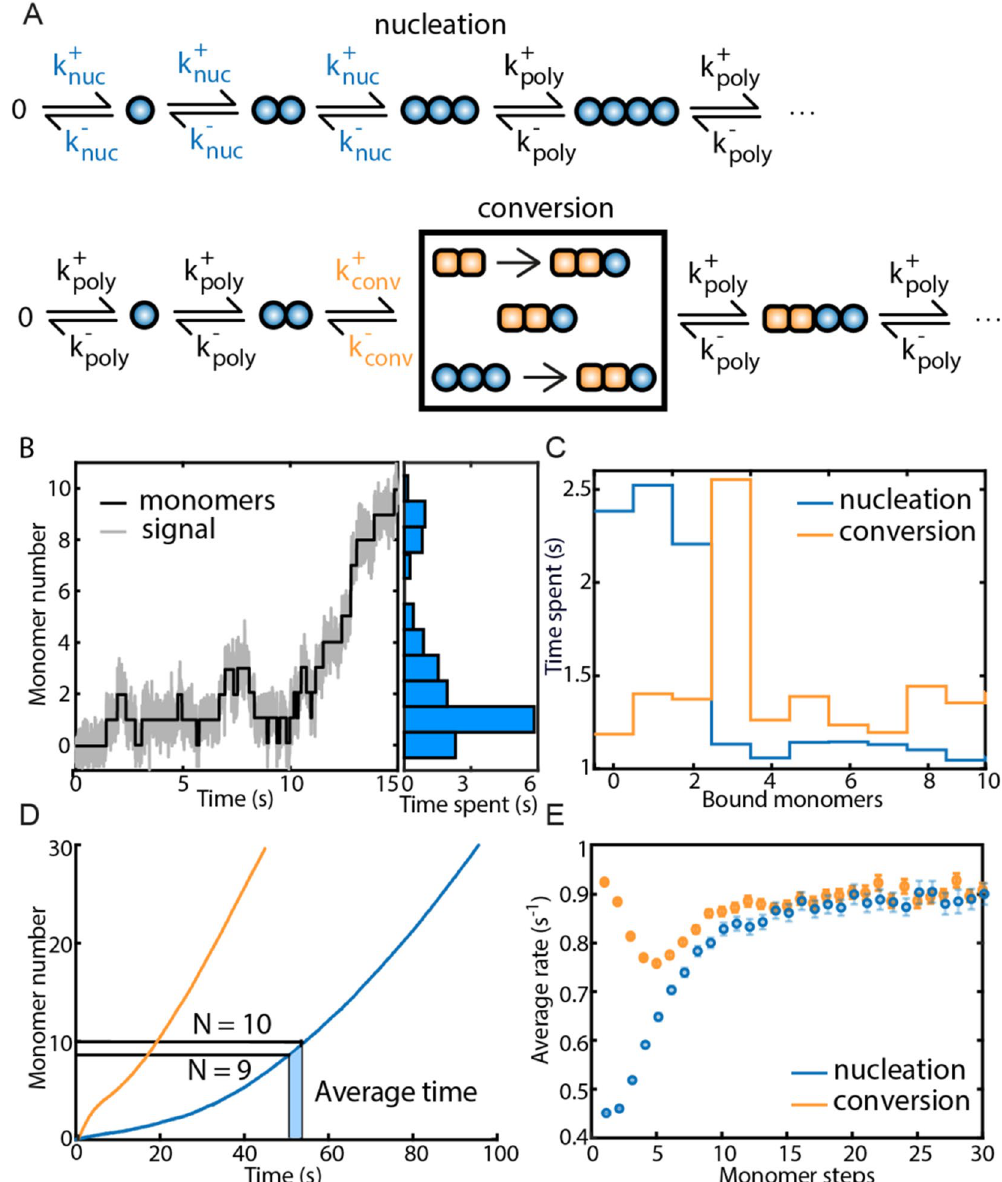
Figure 1. Analysis methods for single-filament data of protein self-assembly. ( A ) Kinetic model of the simulated nucleation and conversion process. For nucleation, k + nuc and k − nuc are changed to k + poly and k − poly as soon as the nucleus size is reached (here three monomers). For a conversion mechanism, only the assembly step associated with conversion (i.e., for example a restructuring of the assembled oligomer) shows k + conv and k − conv . Earlier and later steps follow k + poly and k − poly . For the conversion step, three main possibilities could lead to the slower kinetics as indicated by the black box: (1) the pre-existing oligomer needs to rearrange prior to the next binding event, (2) the restructuring occurs upon binding or (3), the restructuring occurs after binding of the next monomer. All possibilities result in a slower kinetic step and are treated the same in the simulations. ( B ) Example trace of a simulated growth process undergoing a nucleation mechanism with a nucleus size of four monomers (black) with Gaussian noise (grey). The distribution of time spent at a certain oligomer size (blue histogram) contains information about the nucleation mechanism when it is applied to many single oligomer traces ( C ). ( C ) Visitation analysis on a nucleation (blue) or a conversion mechanism (yellow). The visitation analysis identifies the nucleation mechanism as well as the nucleus size for nucleation or conversion. ( D , E ) Average rates analysis. ( D ) Average traces of a nucleation (blue) or conversion (yellow) mechanism. From the average trace of many individual filaments growing from the same starting point, average rates can be calculated from the average time it takes to reach the next oligomer size. ( E ) Average rates plotted versus the monomer number (oligomer size). Different nucleation mechanisms show individual signatures. The nucleation and conversion kinetics were simulated to show slower association rates than the polymerization